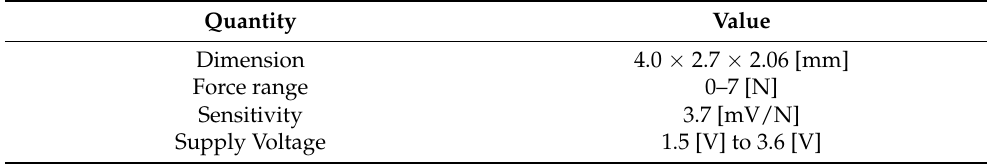
Table 2. Specifications of HSFPAR303A force